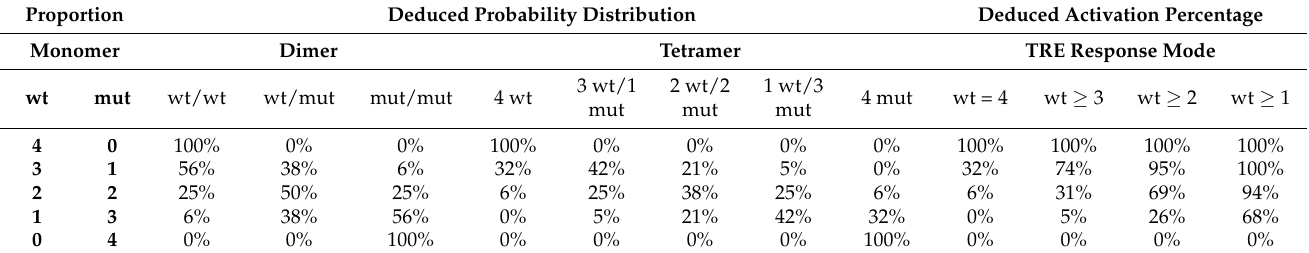
Table 1. Deduction of the probability distribution of each homo- or hetero-dimer or -tetramer and the activation percentage in each TRE response mode based on the given wt/mutP53 monomer